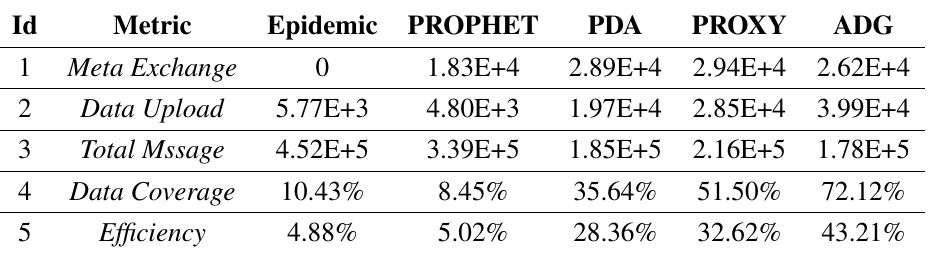
Table 3. Comparison of the overall